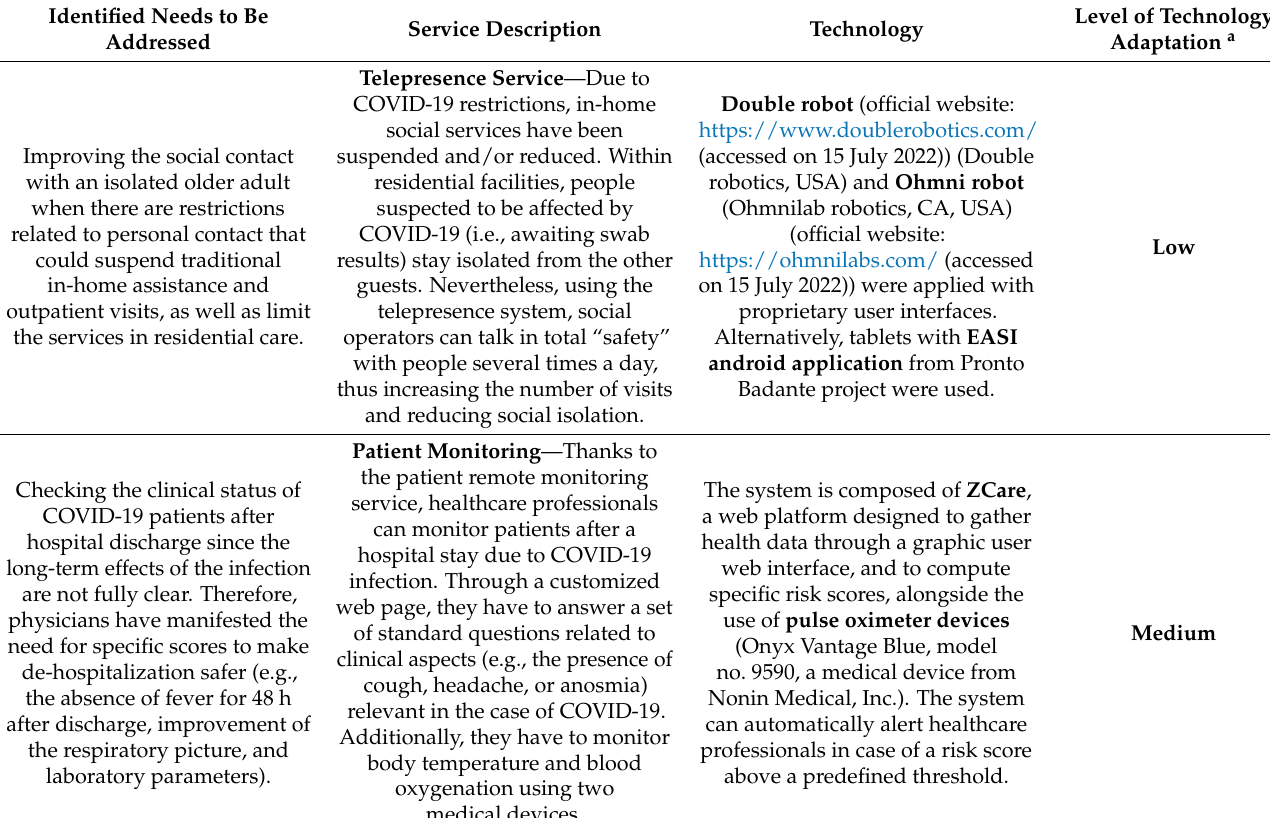
Table 1. Relationship between the needs identified and the implemented